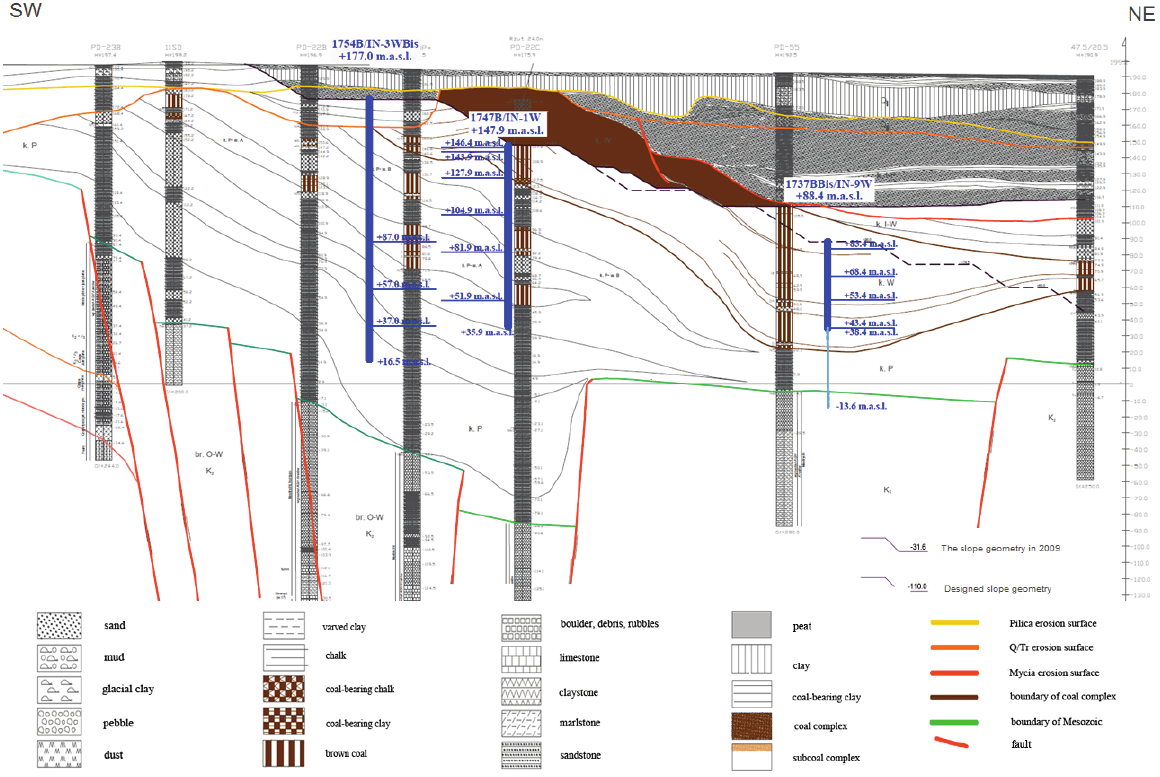
Fig. 5. The Ia’ geological cross-section of the Bełchatów western slope with the location of the inclinometers No.: 1754B/IN-3WBis, 1747B/IN-1W, 1737BBis/IN-9W (based on [2])